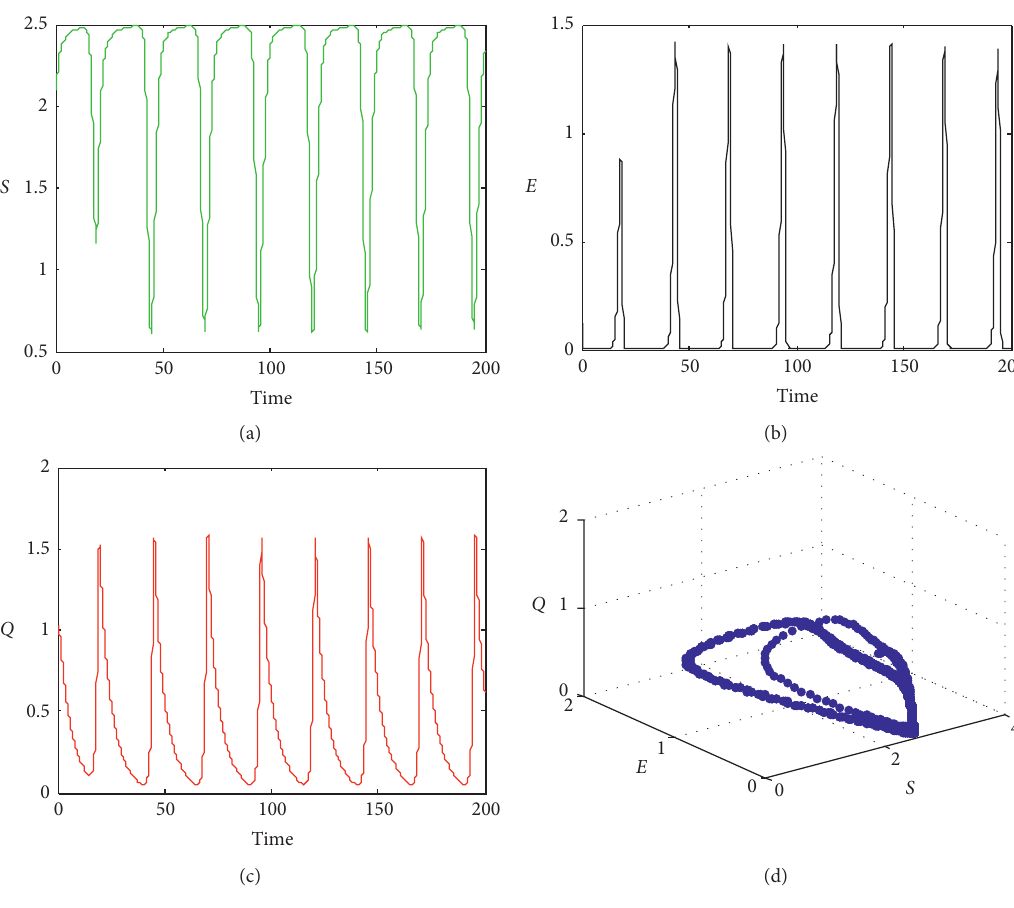
Figure 5: Oscillations at β